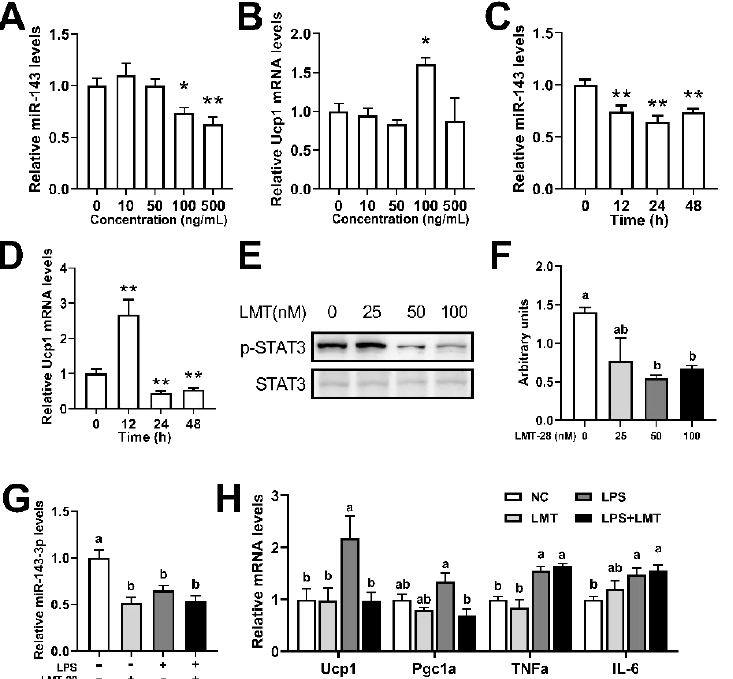
Figure 4. IL-6 increased Ucp1 expression in brown adipocytes while downregulating miR-143. ( A , B ) The miR-143 and Ucp1 mRNA expression in primary brown adipocytes in response to 12 h treatment with various concentrations of IL-6 protein (n = 8). ( C , D ) Time course of miR-143 and Ucp1 mRNA induction in primary brown adipocytes in response to IL-6 (100 ng/mL) treatment (n = 8). ( E , F ) The p-STAT3 and STAT3 protein expression levels in primary brown adipocytes treated with or without LMT for 1 h (n = 3). ( G , H ) The miR-143 and Ucp1 , Pgc1a , TNFa , and IL-6 mRNA expression levels in the primary brown adipocytes treated with or without 50 nM LMT for 1h. Data are presented as the mean ± SEM. * p < 0.05 vs. controls; ** p < 0.01 vs. controls. Different letters above bars represent significant differences, with shared letters representing no significant differences, as determined by a two-tailed unpaired Student’s t -test ( A – D ) or two-way ANOVA followed by Tukey’s post hoc test ( F – H